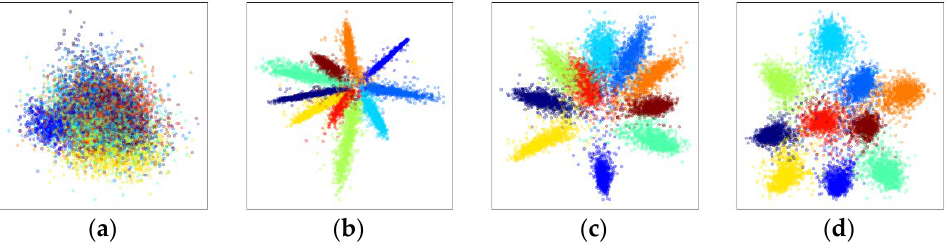
Figure 6. Results of the modified national institute of standards and technology (MNIST) values for changes in the distribution of embedding vectors of each learning method. ( a ) initial state; ( b ) triplet loss; ( c ) stage 1; ( d ) stage 2.